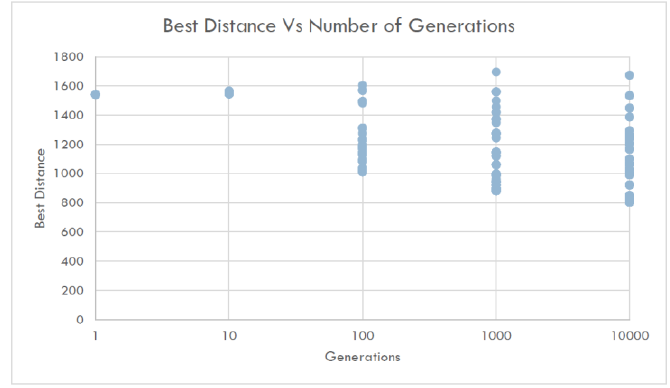
Fig. 5. Route Best Distances Compared to Number of Route Generations